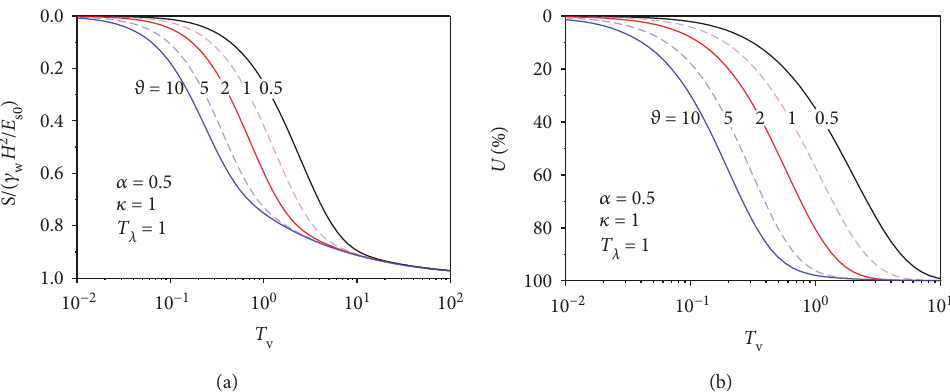
Figure 6: In fl uence of the drawdown speed of the groundwater on the consolidation behavior of the aquifer system. (a) Settlement of aquitard. (b) Degree of